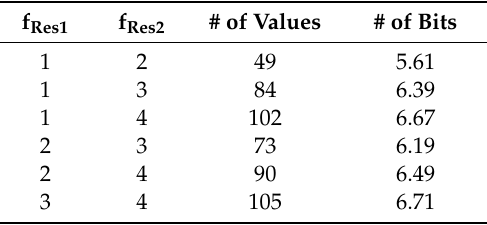
Table 1. Number (#) of encoded states and corresponding number of bits obtained by setting  = 10 MH Z .